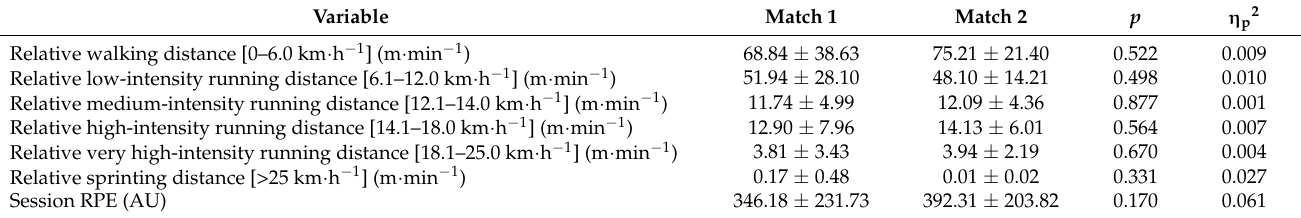
Table 1. Difference between GPS measured variables across the two